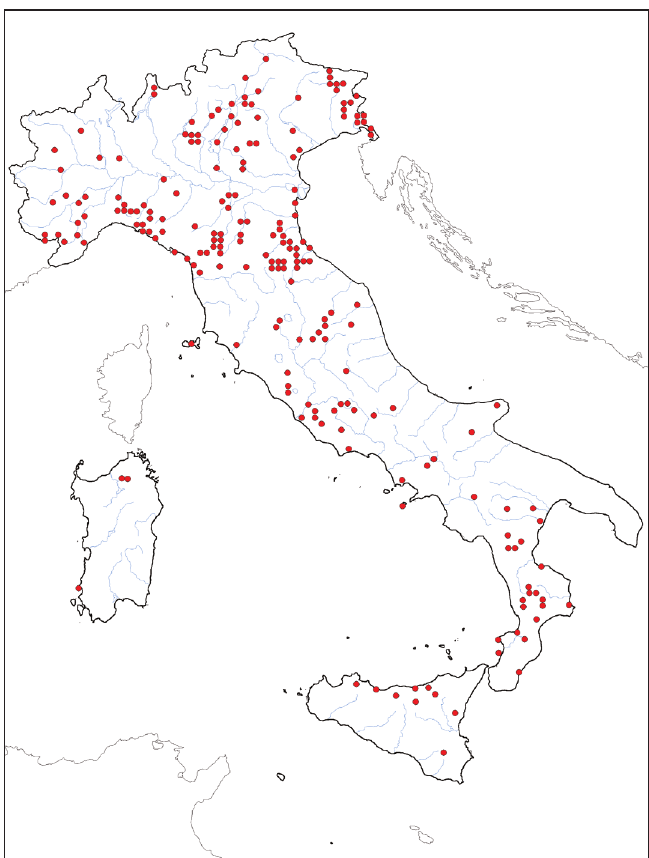
Figure 1. Distribution map of M. asper in Italy (Sama